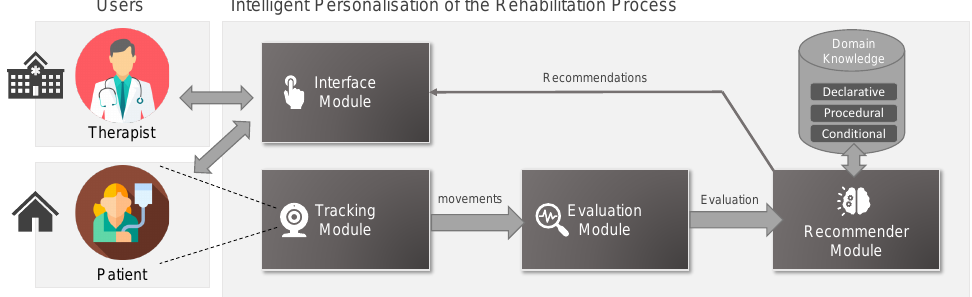
Figure 1. Architectural overview of the proposed